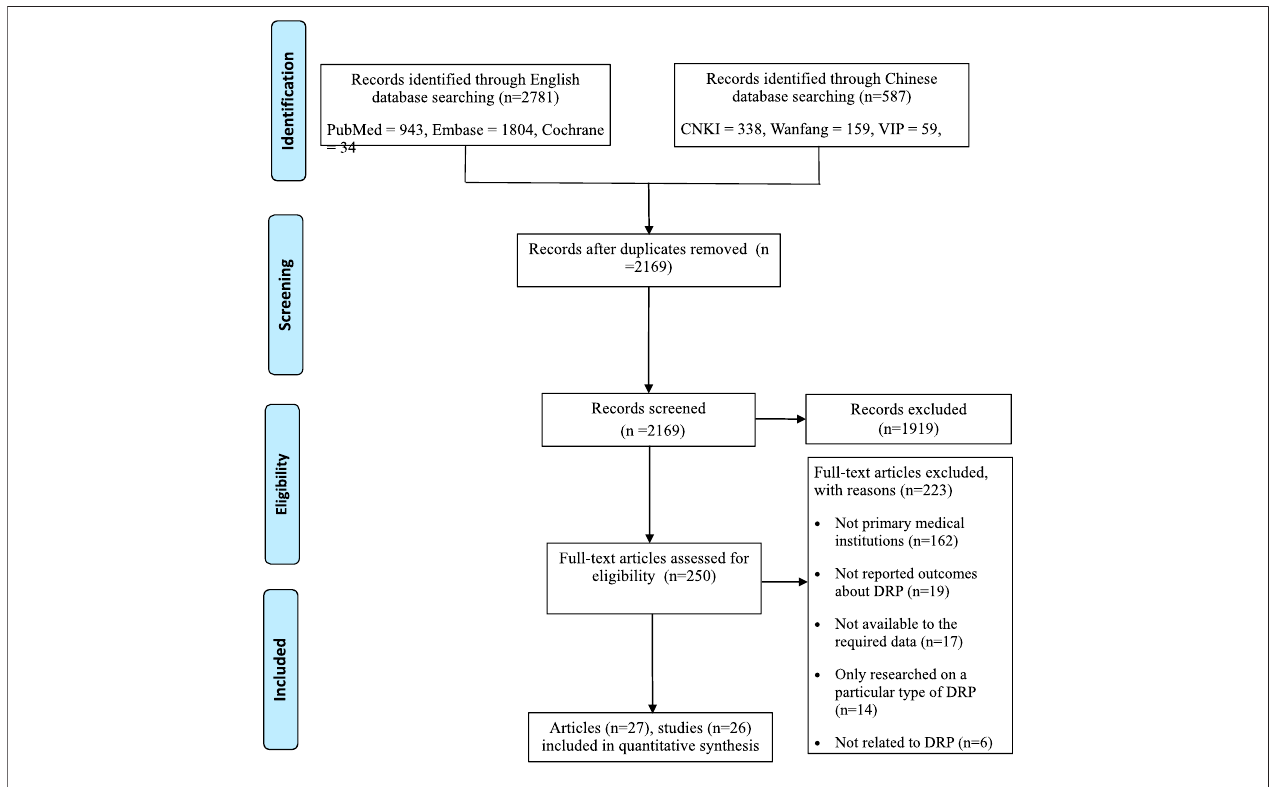
FIGURE 1 | The process of study